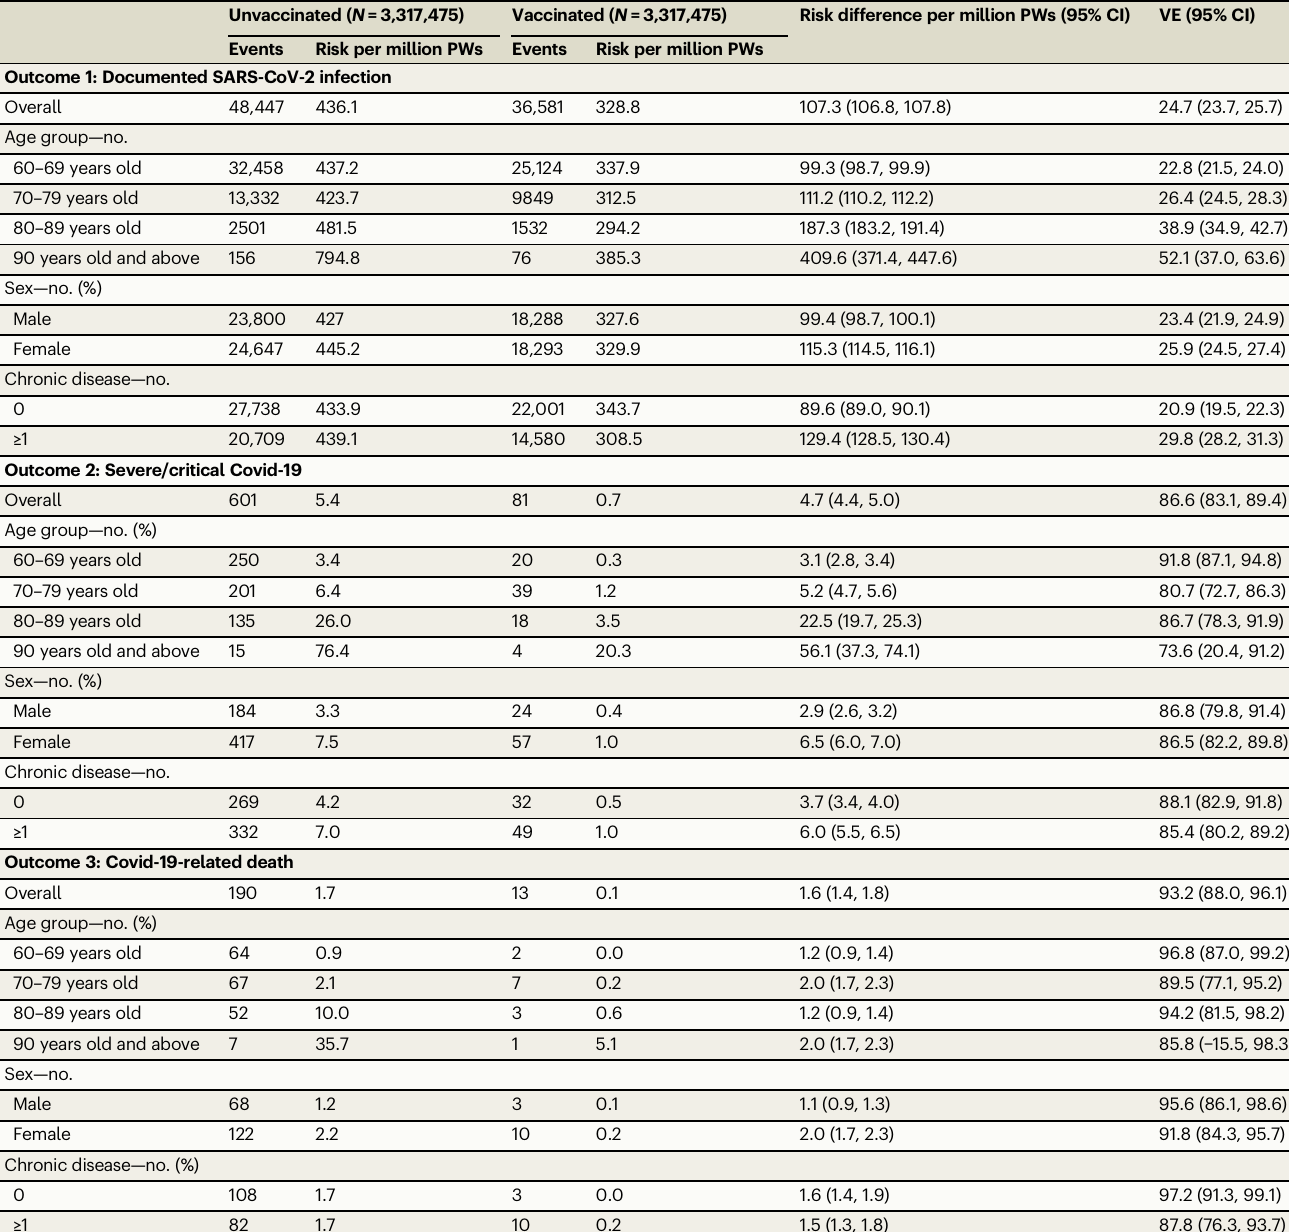
Table 2 | Adjusted vaccine effectiveness of inactivated Covid-19 vaccine against Covid-19 outcomes Unvaccinated ( N =3,317,475) Vaccinated ( N